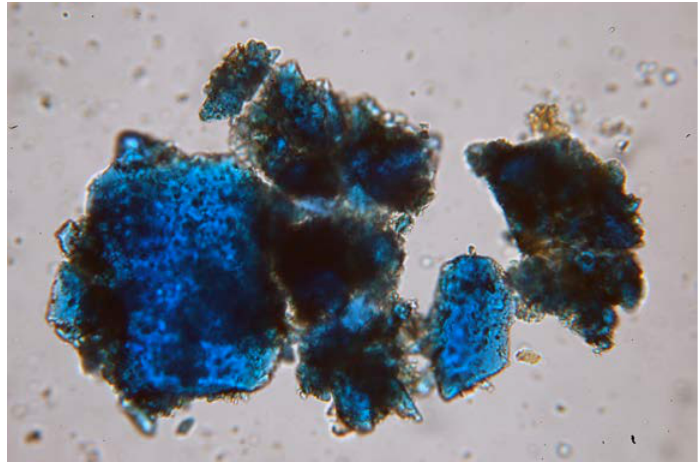
Figure 4. Azurite from Neolithic funerary context at Catalhöyük, Turkey. Plane-polarised light (PPL). 250×, field of view is ~0.5 mm. Photomicrograph by Ruth Siddall and Duygu C ̧ amurcuog ̆ lu.